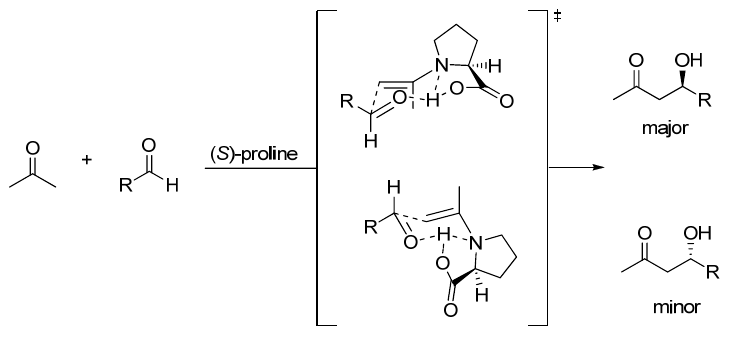
Scheme 13. Generalized mechanism for ( S )-proline-catalyzed aldol reactions based on